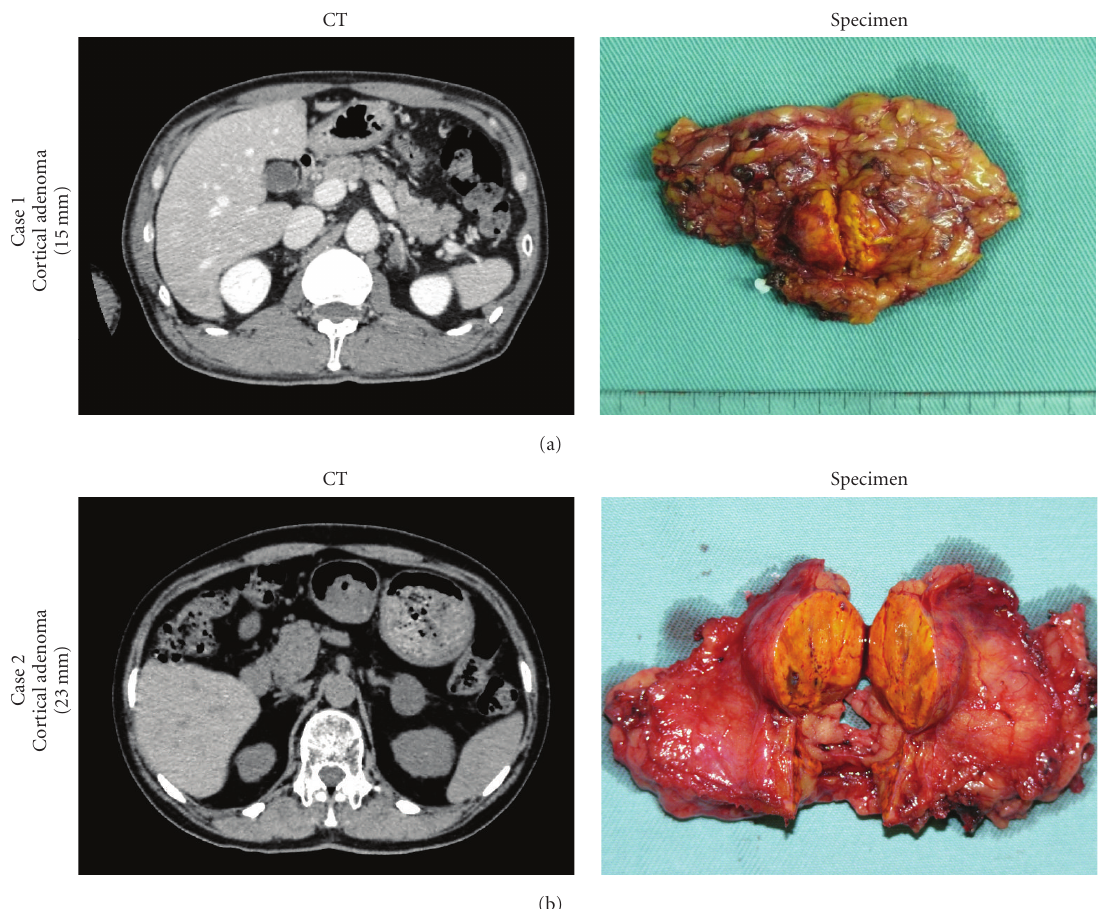
Figure 1: Preoperative CT scans and postoperative specimens of Cases 1 and 2, who underwent left adrenalectomy with combined technique using LESS with an additional accessory